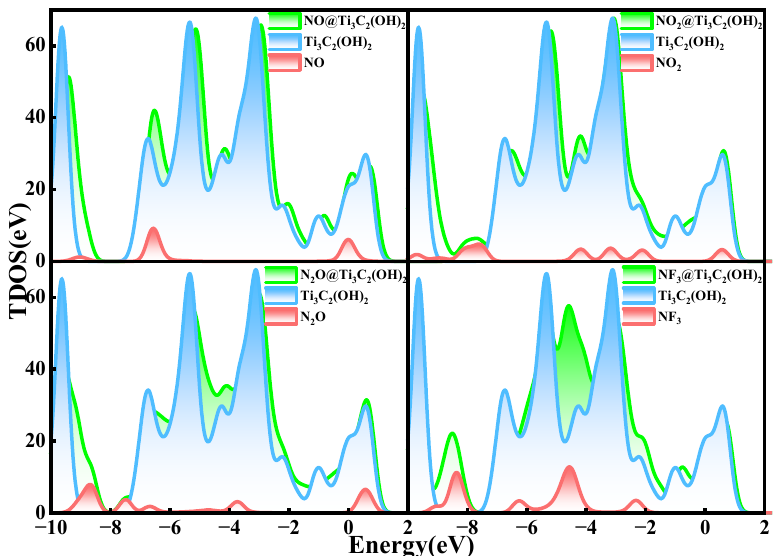
Figure 9. Total electron density of states of Ti 3 C 2 (OH) 2 adsorbing NO, NO 2 , N 2 O, and NF 3 . Figure 10 shows the PDOS for some gas atoms and surface atoms. The N 2p orbital of NO and the H 1s orbital from the surface have the same density of state peaks at 0 eV, − 9 eV of a stronger interaction. The O 2p orbital of NO 2 and the H 1s orbital at 0 eV, − 2 eV,